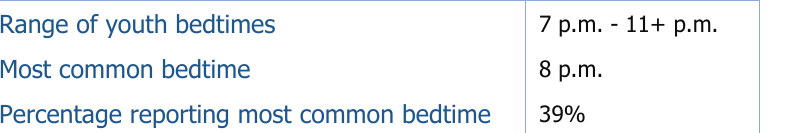
Table 8. Times Youth Cited for Bedtimes Range of youth bedtimes Most common bedtime Percentage reporting most common